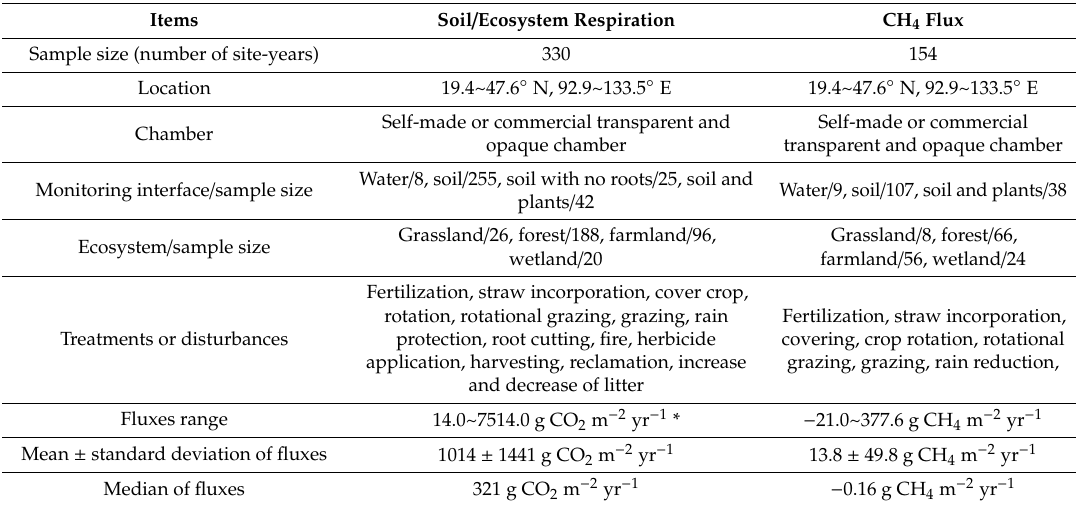
Figure 1. Location of the sampling sites of soil/ecosystem respiration and CH 4 flux from different ecosystems. Table 1. Basic information on the collected data.